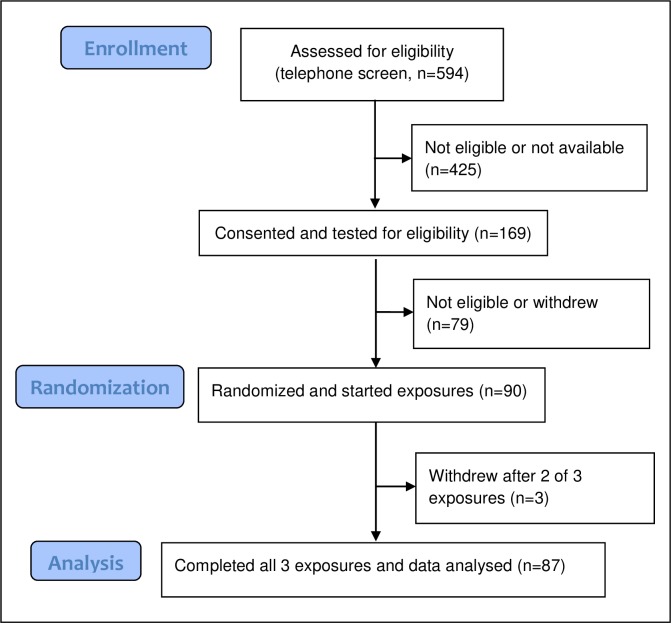
Participant flowchart- number of subjects at each stage of the study.